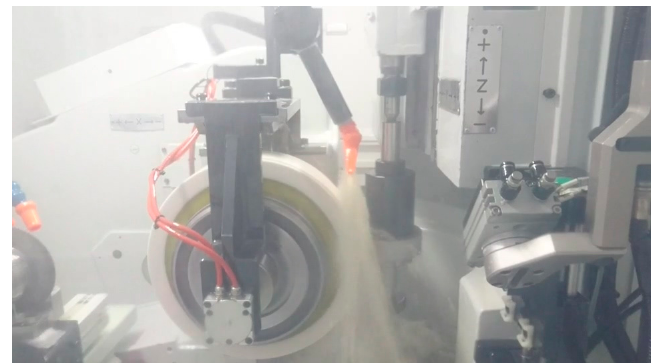
Figure 4. Photograph of grinding process.